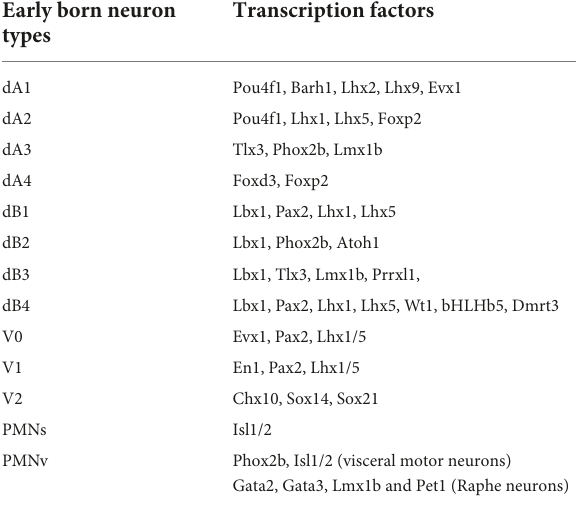
TABLE 2 Transcription factors expressed in neuronal cell types emerging from the developing